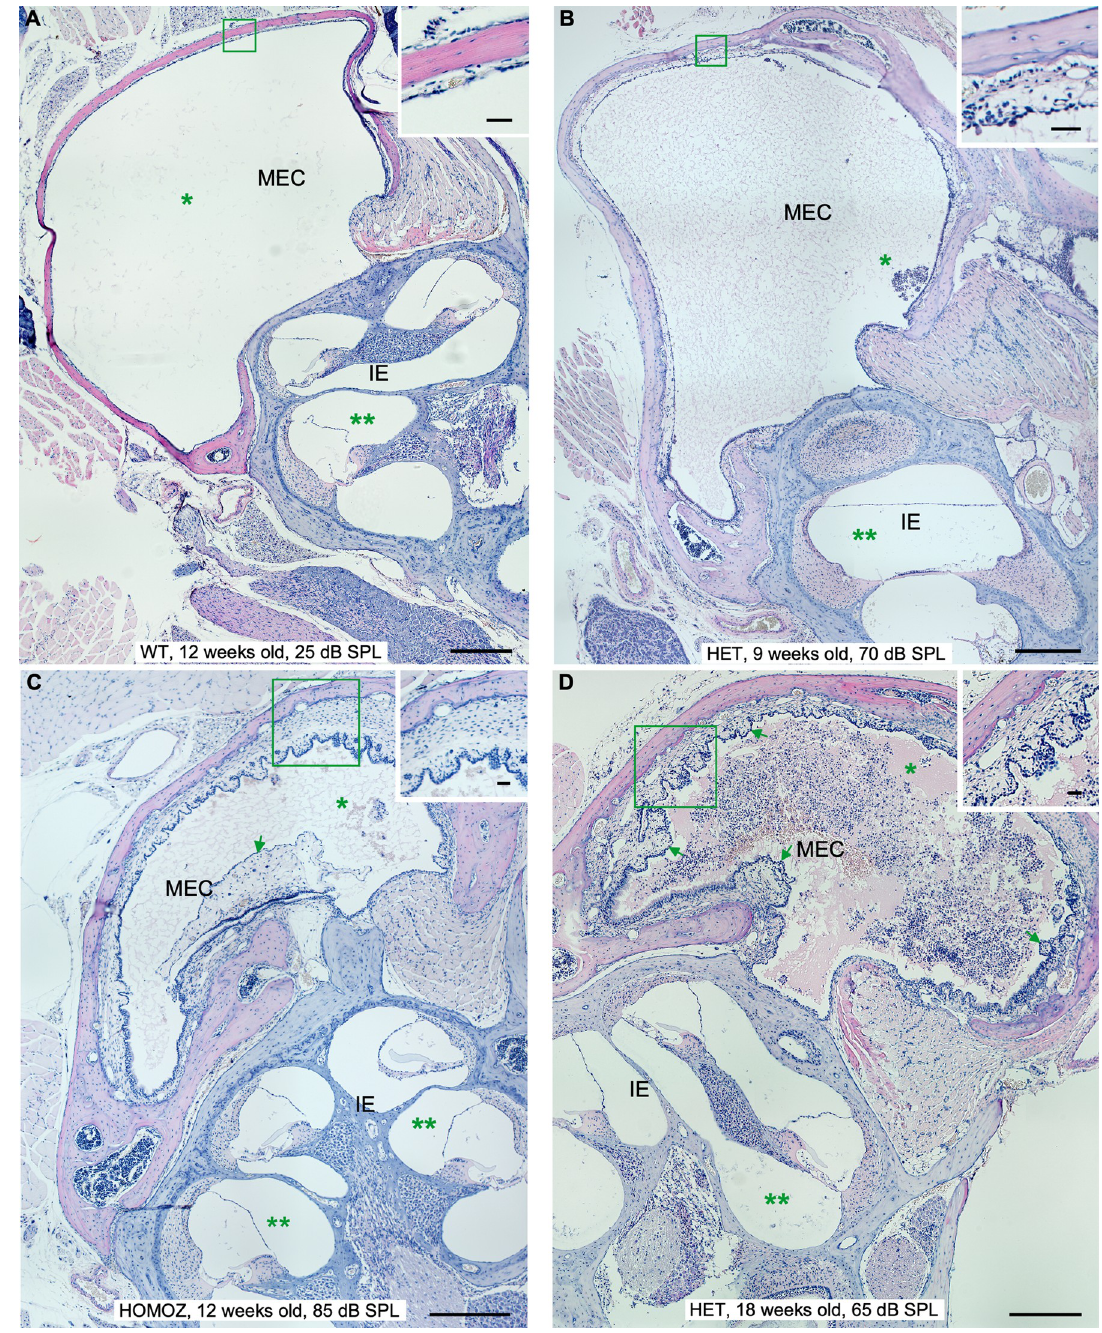
Fig 2. Manifestations of middle ear inflammation in STAT1-KO mice at different ages. From mild to chronic inflammation degrees in middle ear and cochlea. ( A) Wild type (WT) mice at 18 weeks of age, heterozygous (HET) STAT1-KO mice at 9 (B), homozygous (HOMOZ) mice at 12 (C) and heterozygous (HET) mice at 18 (D) weeks of age. Clear appearance of middle ear cavity (MEC) of wild type in comparison to MEC of knockout mice filled with watery effusion with few inflammatory cells (asterisk in B, C) and large number of inflammatory cells (asterisk in D). The cochlea showed no effusion in wild type (two asterisks in A) or effusion with few inflammatory cells in knockout mice (two asterisks in D). The thickness of the middle ear epithelium is greater in knockout mice (insets). Additional signs of inflammation in knockout mice included fibroblastic tissue (arrow in C) and fibrous polyps (arrows in D). Scale bars 300 μ m. Inset scale bars 30 μ m. CO, cochlea; EAC, external auditory canal.